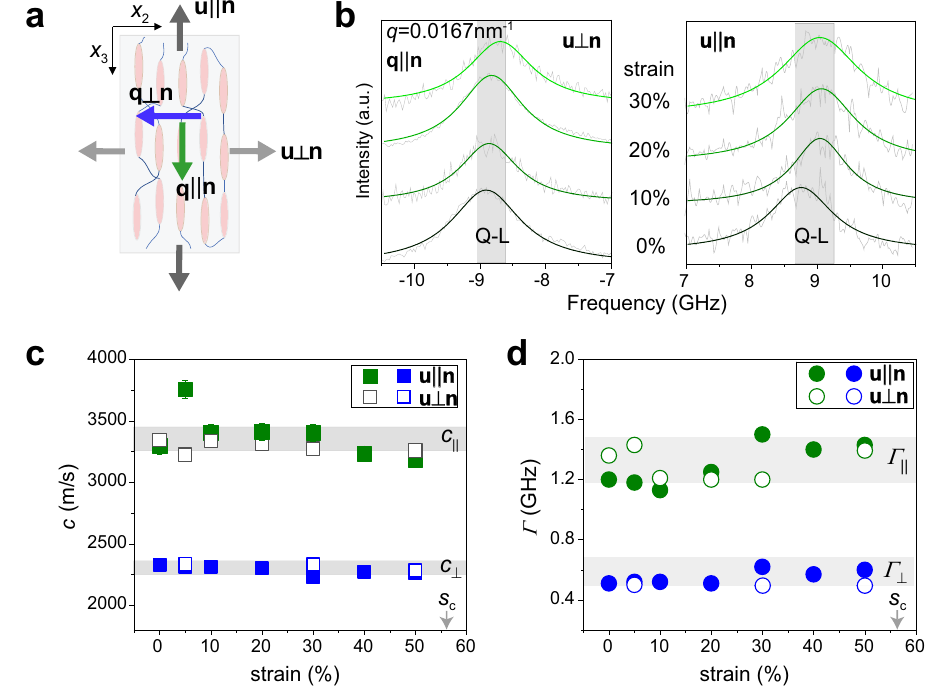
Fig. 3 | Strain-dependent elasticity. a Scheme of the aligned LCE under uniaxial stretching.Theuniaxialstretchingdirection(grayarrows)iseitherparallel( u || n )or perpendicular ( u ⊥ n ) to the director n in the x 2 - x 3 plane, and the phonons at orthogonal directions ( q || n, q ⊥ n ) are selectively probed. b Evolution of polarized BLSspectrafor u ⊥ n (left)and u || n (right),respectively,atagiven q beingparallelto n . The BLS spectra (gray lines) are well represented by Lorentzian shape (green